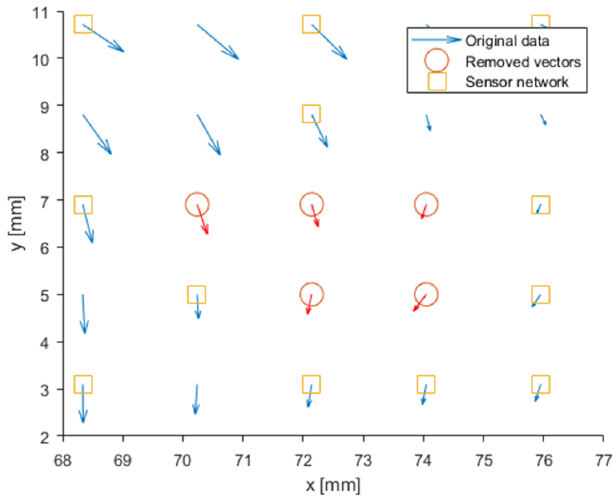
Figure 11. Example of clumped removed vectors and reconfigured sensor network.